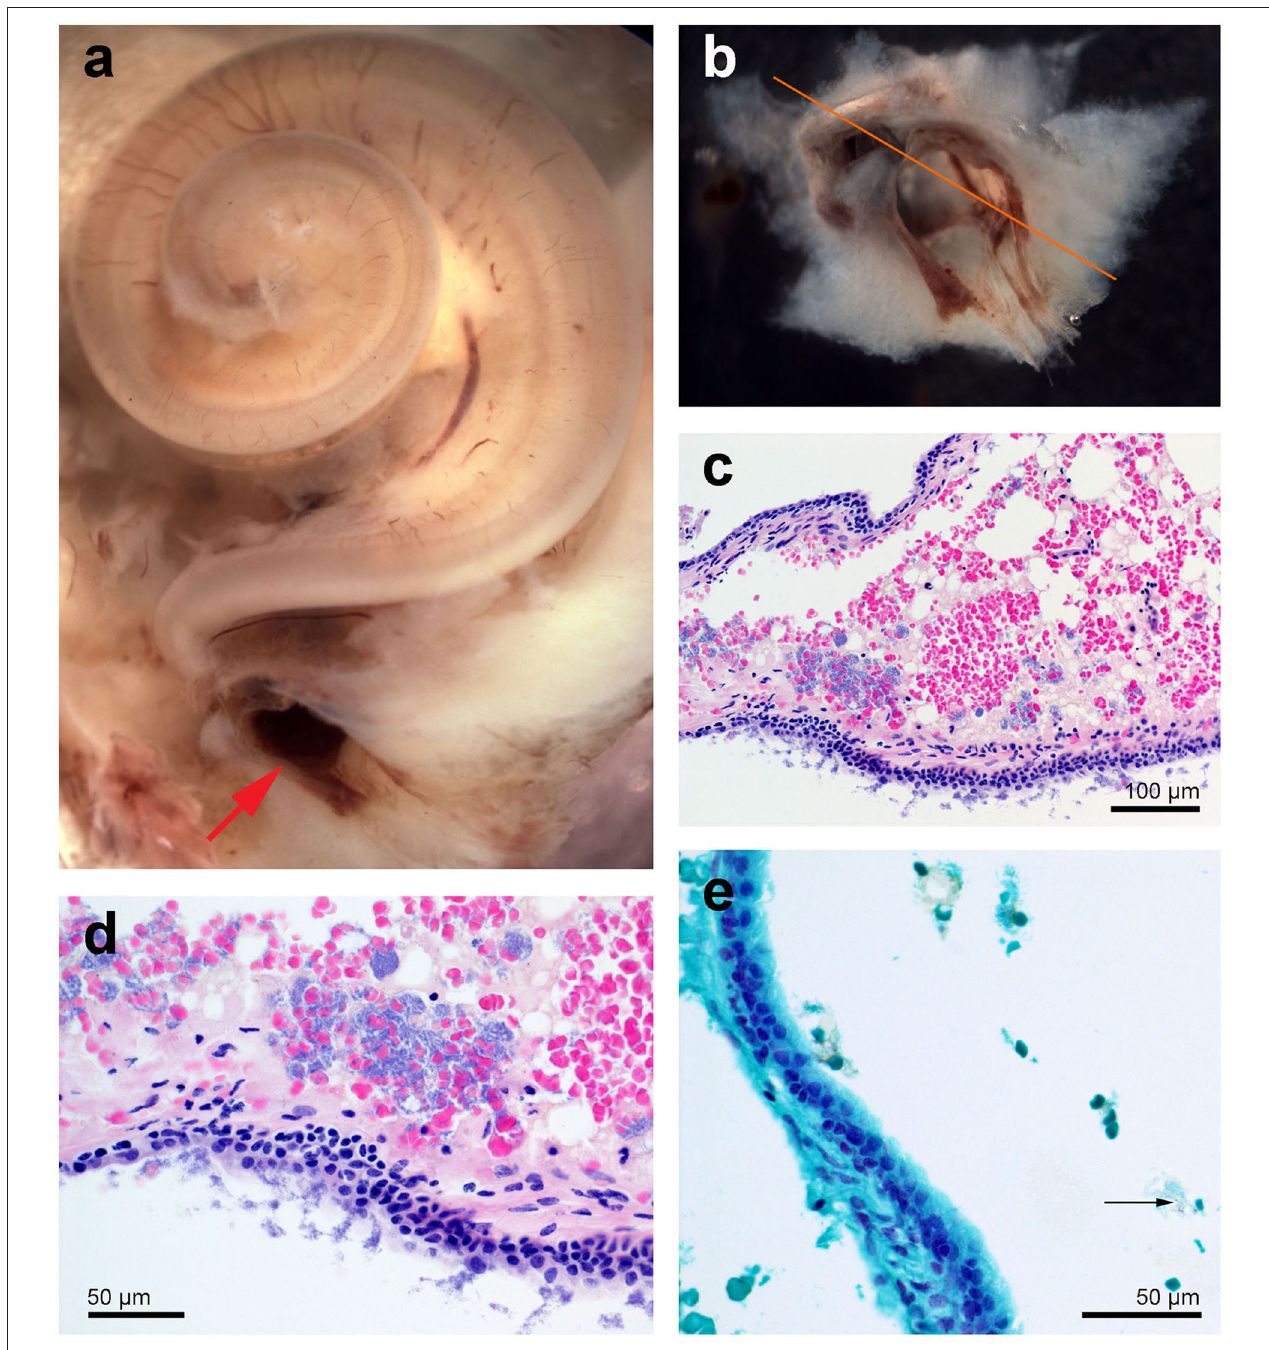
FIGURE 5 | Right cochlea from the beluga Qila. (a) General picture. Note there is multifocal congestion with hemorrhage at the round window (red arrow). (b) Detail of the round window niche after being sampled for histopathology. (c,d) Histopathology of focally extensive acute hemorrhage admixed with vacuolated proteinaceous deposits and dense clusters of extracellular (c,d) and rare intracellular [arrow in (e) ] Gram positive cocci. Sections (c,d) were stained with hematoxylin-eosin and (e) with Twort’s gram stain. There was positive labeling for hair cells and associated three controls were negative. Based on observation from immunofluorescence, there was no evidence of hearing loss innervation throughout the cochlear spiral ( Figures 7e,f ). at the level of the hair cells or innervation of the right Artifact associated with post-mortem decomposition was more inner evident in the upper basal and lower apical turns. The